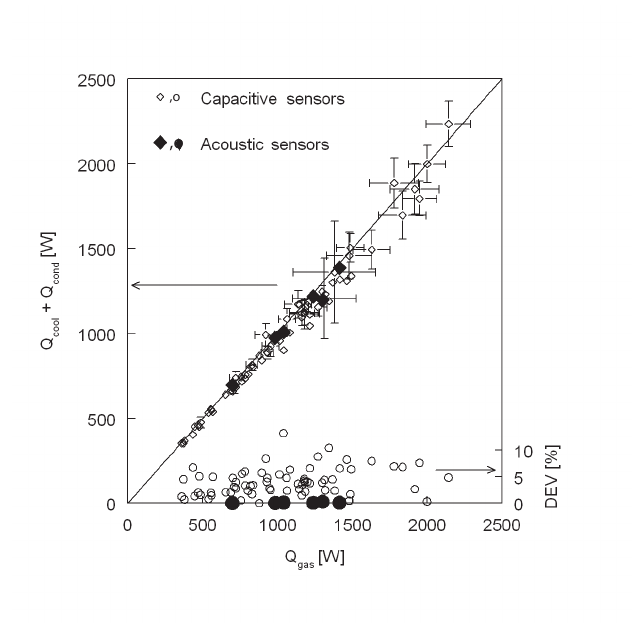
Figure 8. Energy balance measured in condensing steam-air flow with capacitive humidity sensors and acoustic humidity